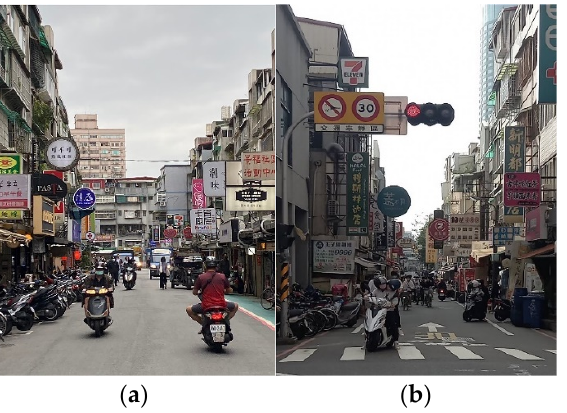
Figure 1. University neighborhoods in Taiwan. ( a ) A university neighborhood in Taipei City. ( b ) A university neighborhood in Tainan City. Source: Pictures taken by the author (H.-Y.L.).